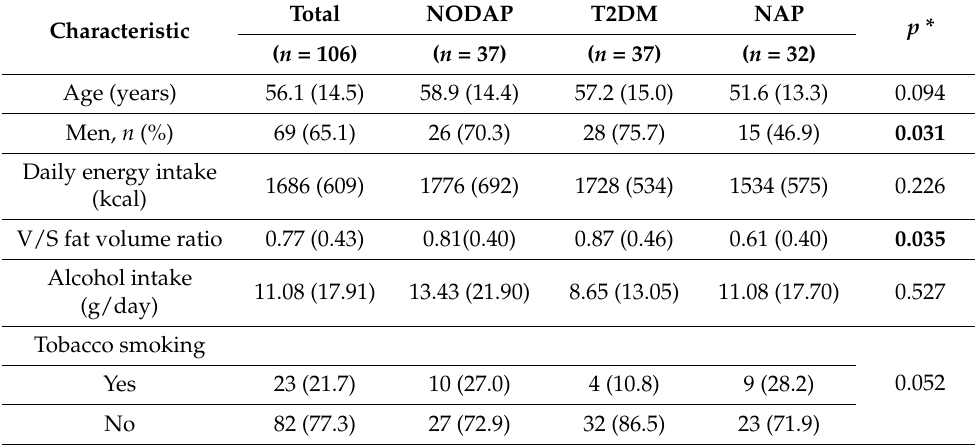
Table 1. Characteristics of the study